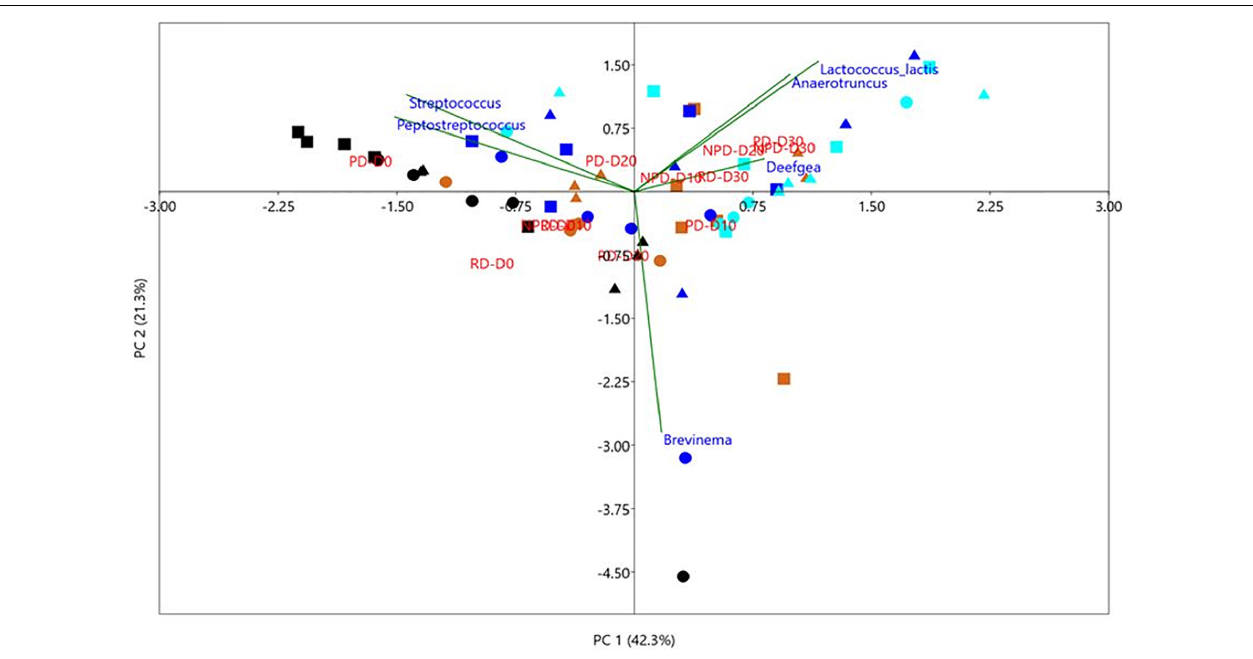
FIGURE 6 | Principal component analysis (PCA) plot showing the correlation of the top six operational taxonomic units (OTUs) in the gut bacterial community of rainbow trout with diet and day interval. Reference diet (0), preconditioned diet ( (cid:3) ), non-preconditioned diet ( (cid:49) ). Different colors represent day interval; days 0